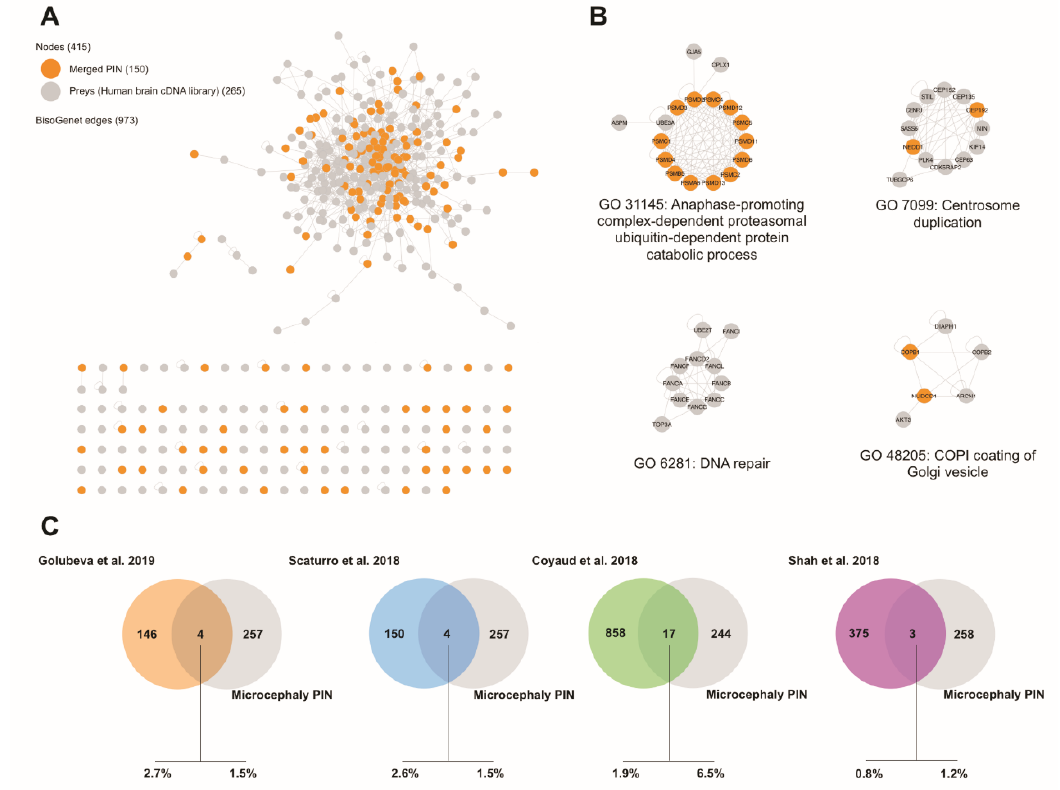
Figure 5. Integration of Microcephaly-associated PIN with the merged ZIKV PIN. ( A ) Network of the interactions identified by this study, and proteins related to the Microcephalic phenotype (see Experimental Procedures). ( B ) Clustering of bait sets according to overlapping protein complexes among the integrated network using ClusterONE (Version 1.0) [29]. Gene ontology of these networks were obtained by the Cytoscape plugin, BINGO [30]. Proteins identified in this study are represented as orange nodes. ( C ) Venn diagrams represent the overlap between the Microcephaly-associated PIN and the individual ZIKV PINs.